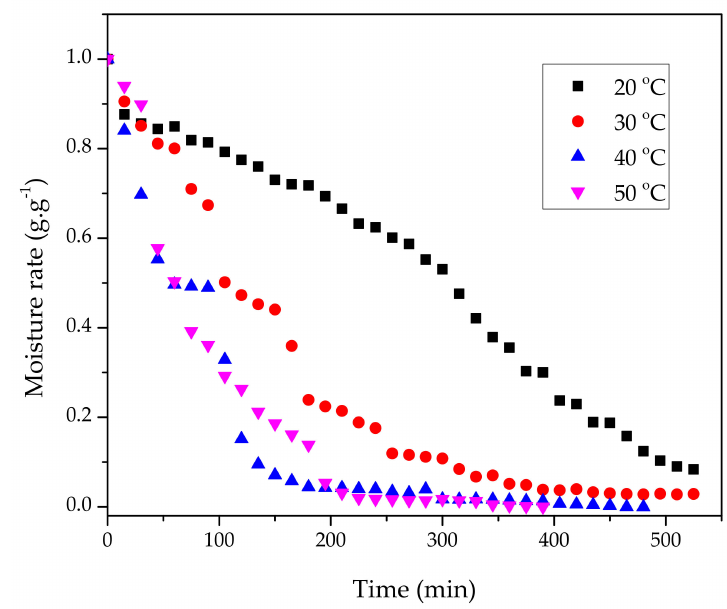
Figure 2. Variation of moisture rate (MR) over time at a temperature range of 20–50 ◦